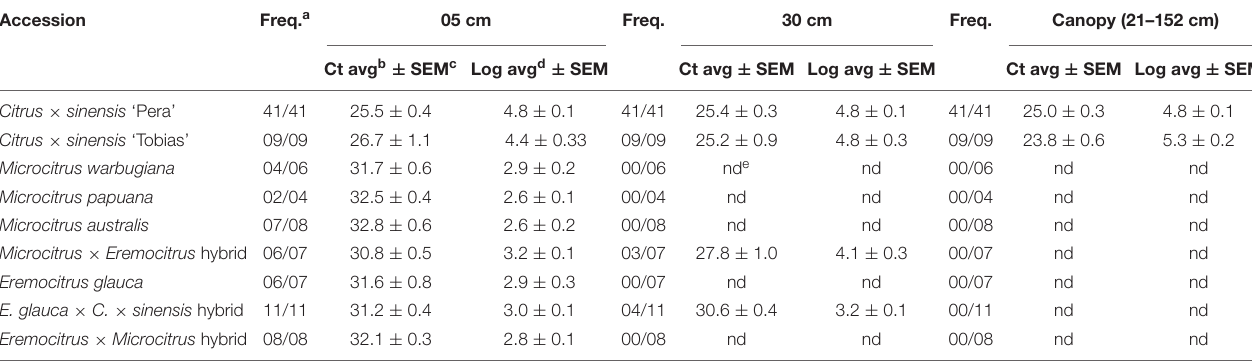
TABLE 4 | ‘ Candidatus Liberibacter asiaticus’ detection in scions from each plant of Category 3 accessions plus sweet orange controls. Bark samples were taken at different distances from the rootstock (5 cm, 30 cm and at the canopy) at 24 months after inoculation.